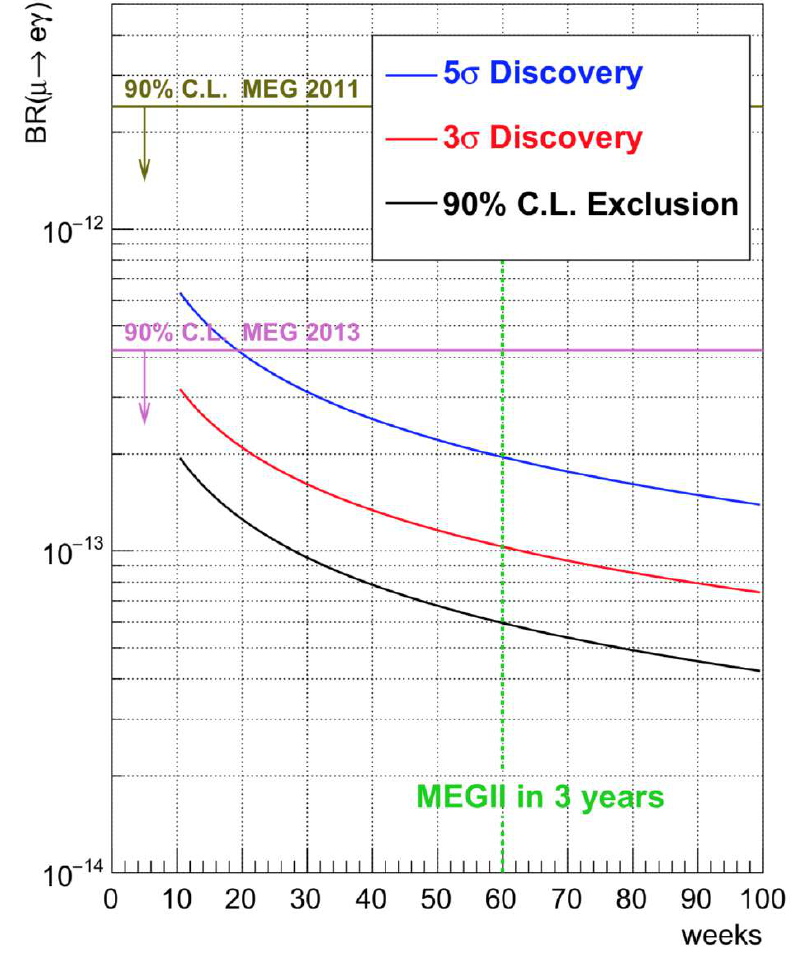
Figure 3: Sensitivity plot as a function of the DAQ